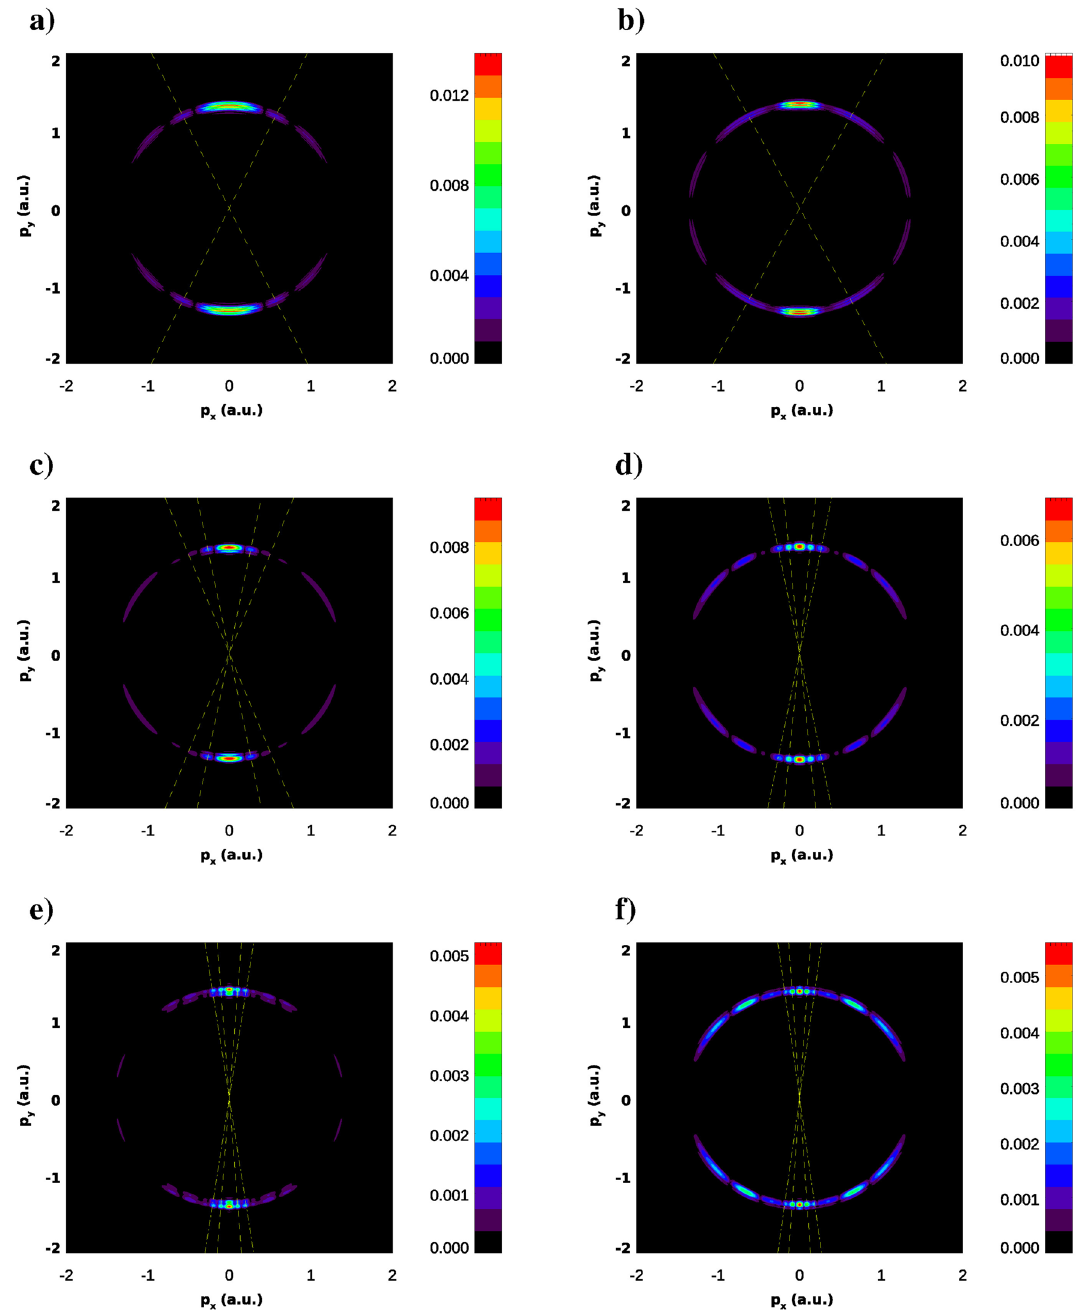
Figure 4. Photoelectron momentum distributions in the ( x , y ) plane for various IR field strengths and 1 a.u. PMD is exponentiated ( P ( p x , p y ) 1 / 3 is shown) for improving visibility frequency of the probe field (cid:31) = 0.02387 a.u. ( a ), E 0 of the patterns. IR field strengths are: E 0 = 0.125 a.u. ( e ), E 0 0.15 a.u. ( f ). Lines show directions to low order maxima of the interference a.u. ( d ), E 0 = =